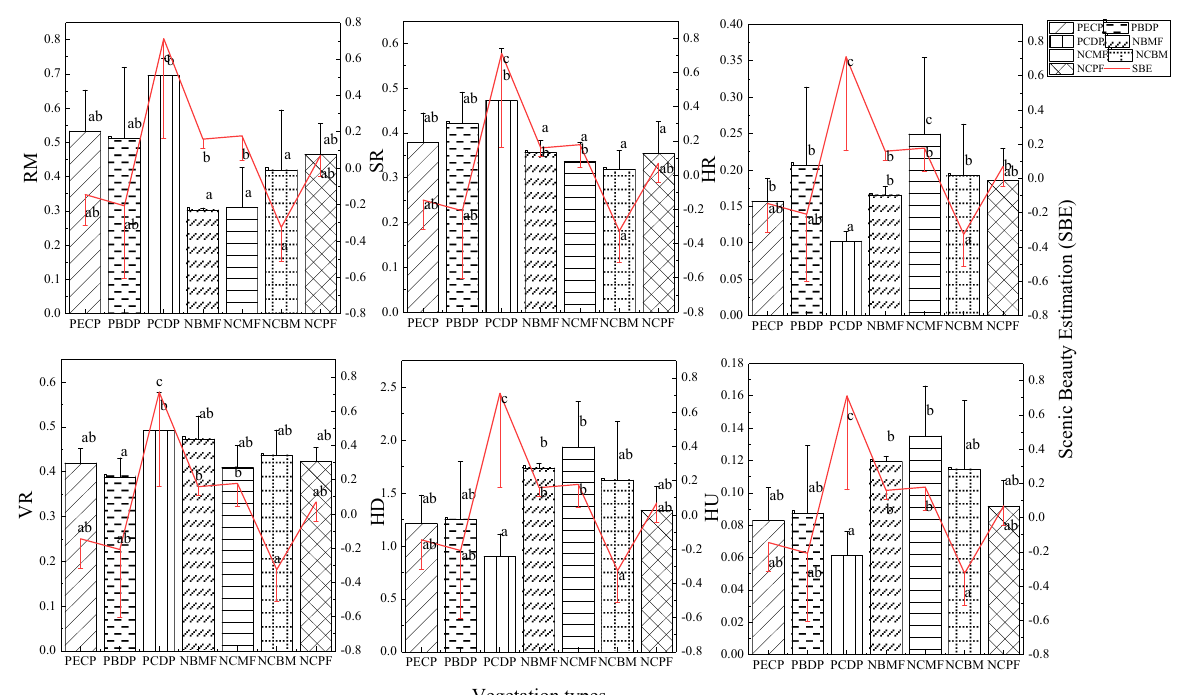
Figure 4. Vegetation color index and SBE. Different lowercase letters (a, b, ab, c) in the figure indi-cate significant differences in SBE of different vegetation types ( p < 0.05).